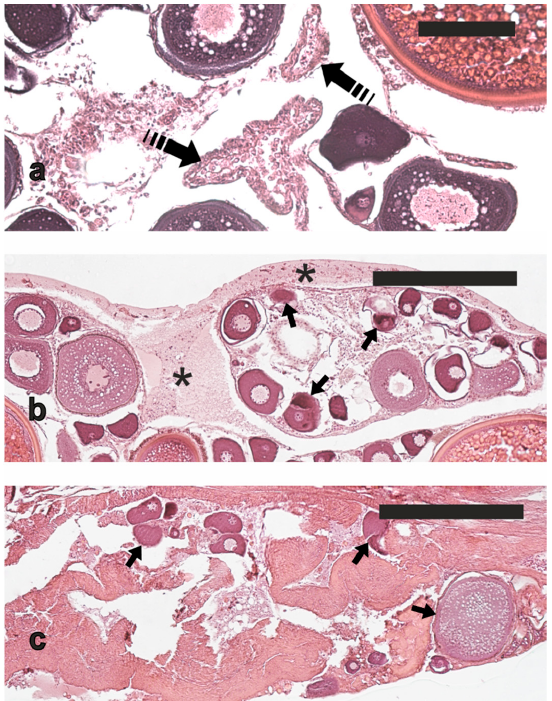
Figure 5. ( a ) Micrographs of ovary sections from a specimen sampled in July showing post-ovulatory follicles (POFs), a sign of recent spawning. ( b , c ) Micrographs of ovary sections from fish sampled in July showing a reduction in oocyte density, a plasma transudate rich in leucocytes (dark spots in the transudate) and a degeneration of pre-vitellogenic follicles. Haematoxylin-eosin staining. Magnification bars: 100 µ m in ( a ) and 300 µ m in ( b , c ). Arrow, degenerating pre-vitellogenic follicles; asterisk, plasma transudate; dashed arrow, post-ovulatory follicle. The percentage of oocytes in the different developmental stages and the trend of mean diameter of the most advanced oocyte populations are shown in Figure 6.